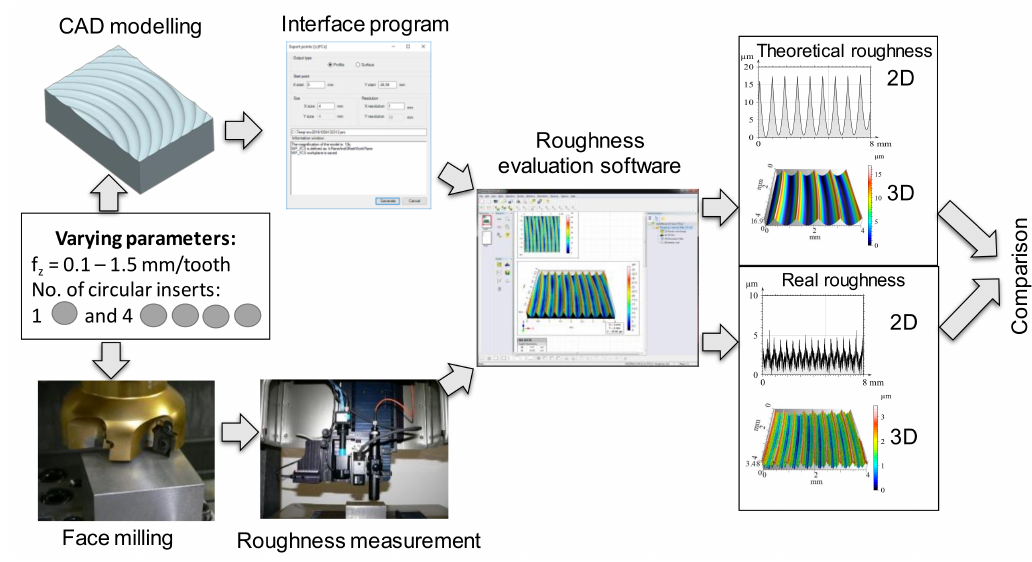
Figure 1. The applied investigation method.